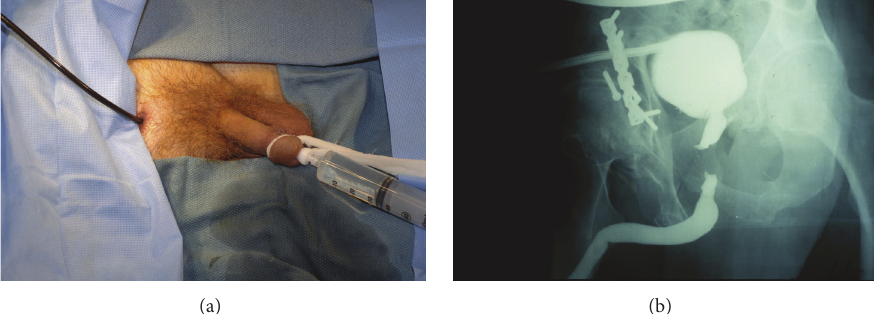
Figure 3: (a) A RUG is performed as contrast is simultaneously injected into the posterior urethra through the flexible cystoscope, with the tip in the distal prostatic urethra. (b) Imaging accurately demonstrating the length and location of the